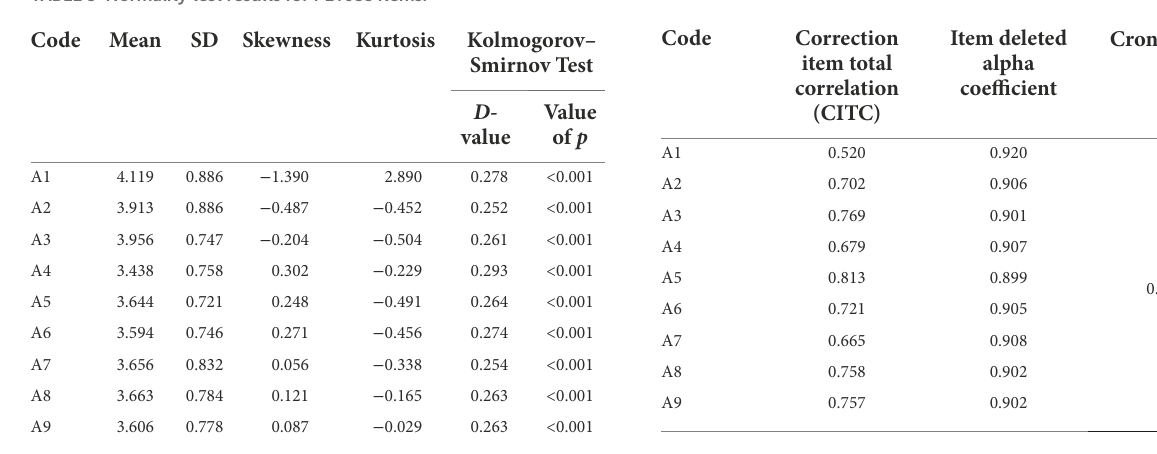
TABLE 4 Corrected item correlation statistics for PETJSS items.